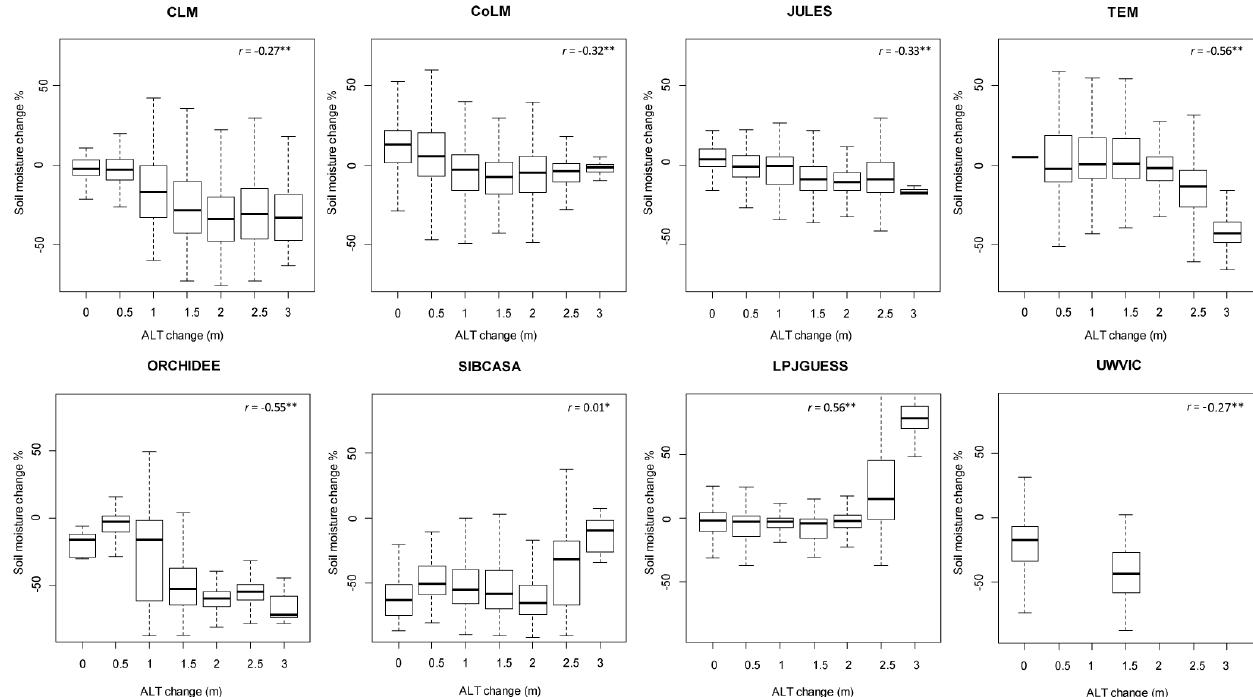
Figure 4. Responses of August near-surface (0–20cm) soil moisture to ALT changes. Each box represents a range of ± 0 . 25m of ALT change. ALT and soil moisture change are calculated as the 2270–2299 average minus the 1960–1989 average for cells in the initial permafrost domain of 1960. For cells where ALT exceeded 3m (no permafrost) during the 2270–2299 period, we subtracted the initial active-layer thickness (1960–1989 average) to 3m. Population Pearson correlations ( r ) significant at ∗ p < 0 . 01 and ∗∗ p < 2 × 10 − 16